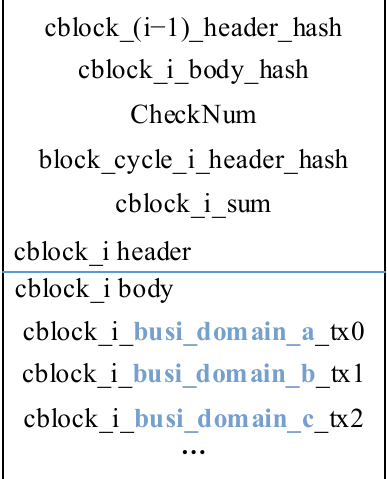
Figure 7. The main-side chain cross-anchoring structure. The structure of the checking block is illustrated in Figure 8. The block header of the checking block records the block header hash cblock_(i −1 )_header_hash of the previous checking block, the block body hash cblock_i_body_hash of the checking block, the check- point number CheckNum , as well as the block header hash block_cycle_i_header_hash of the corresponding mainchain cycle point block block_cycle_i . Meanwhile, the Merkle tree is constructed for the block headers of the mainchain blocks in the mainchain cycle interval, and the root hash of the Merkle tree is obtained as the mainchain cycle interval summary